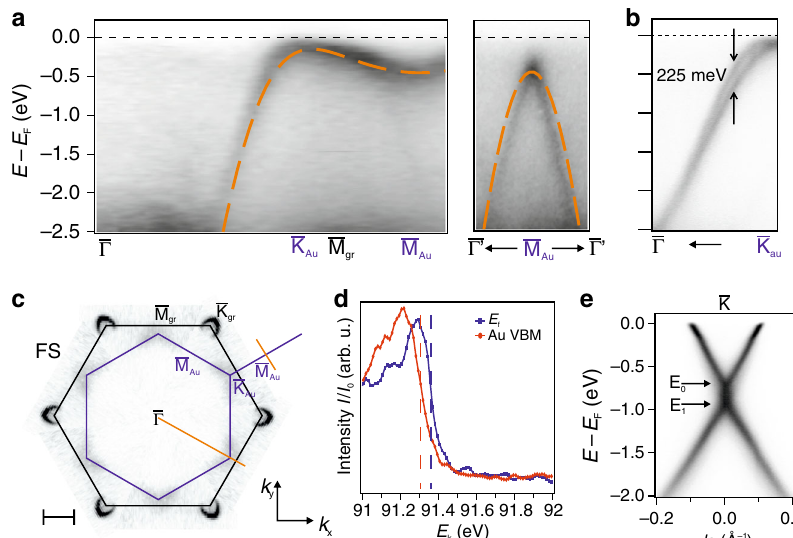
Fig. 1 Electronic properties of 2D Gold. a ARPES cut along the diagonal orange line in panel c , showing only the Au bands dispersion. In the right panel the spectrum cuts along the short orange line in panel c . The orange dashed lines superimposed to the data are the TB bands as described in the text. b Au bands dispersion along the k y direction highlighting their spin-orbit splitting Δ SO . The photon energy for panels a and b is 95 eV. c Fermi surface of the system measured by ARPES. The fi gure is the result of the sixfold symmetrisation of a measurement. Scale-bar corresponding to 0.5 Å − 1 . d Normalized line pro fi les extracted along the graphene π -band and the K point (cf. Supplementary Fig. 1). e Dispersion measured along k y at the K point with 40 eV Au Gr photons, showing graphene ’ s Dirac cone.